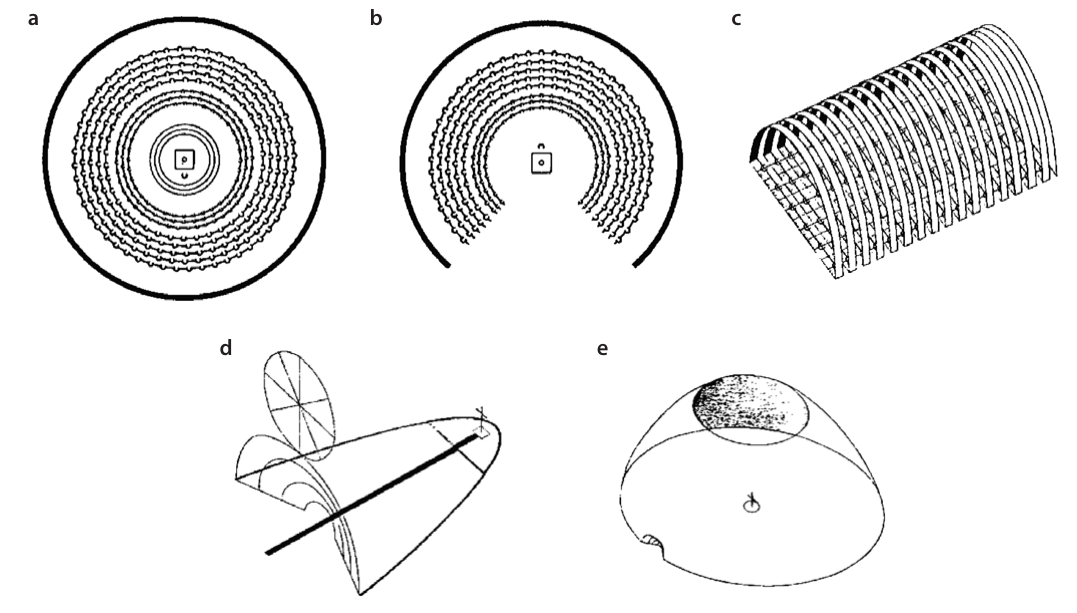
Fig. 2. R. Schwarz, conceptions of churches plans: a – Holy Intimacy , b – Holy Departure , c – Holy Journey